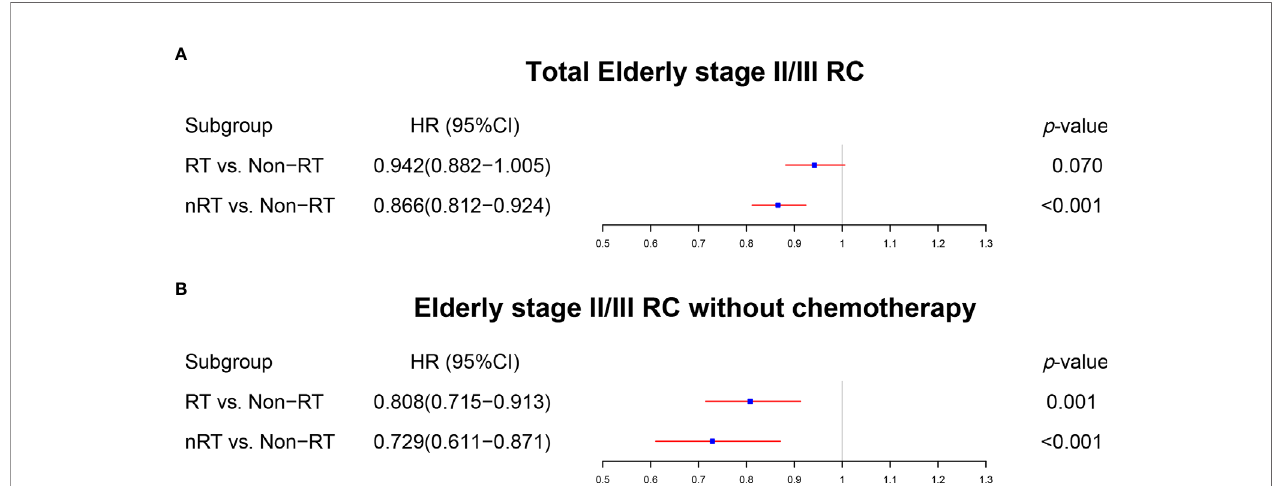
FIGURE 6 | The forest plot was used to show the results of the multivariable Cox regression in elderly stage II/III RC. (A) RT vs . non-RT and nRT vs . non-RT in total elderly stage II/III RC patients. (B) RT vs . non-RT and nRT vs . non-RT in elderly stage II/III RC patients without chemotherapy. (The results were extracted from Table S5 ).